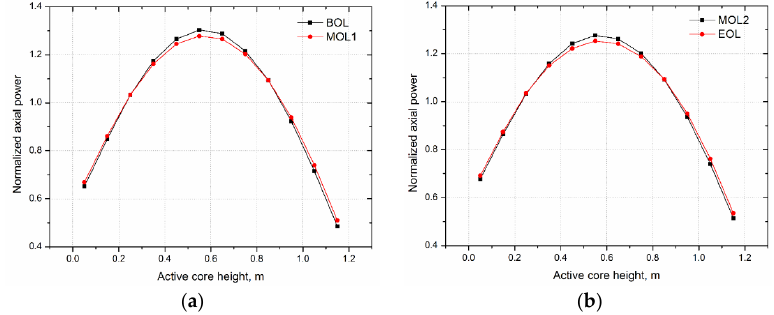
Figure 12. Normalized axial power distributions of the MMR core. ( a ) BOL and MOL1 of the first-half cycle core; ( b ) MOL2 and EOL of the second-half cycle core.